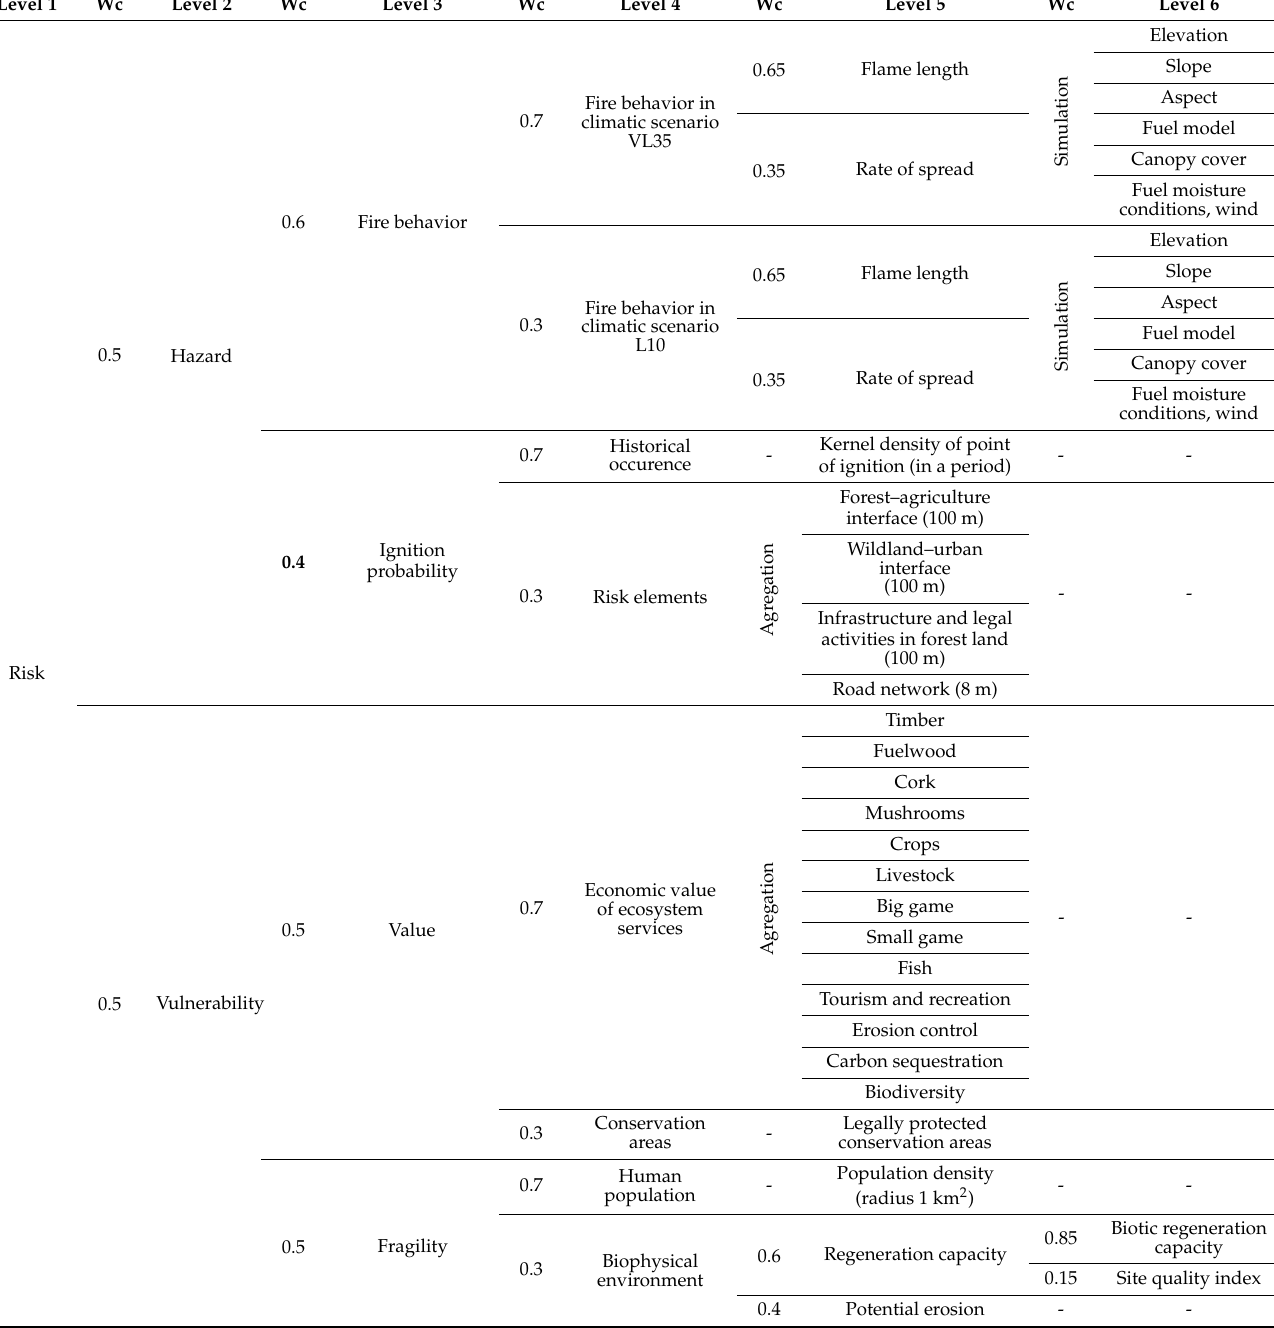
Table 7. Risk index by components and weight coefficients